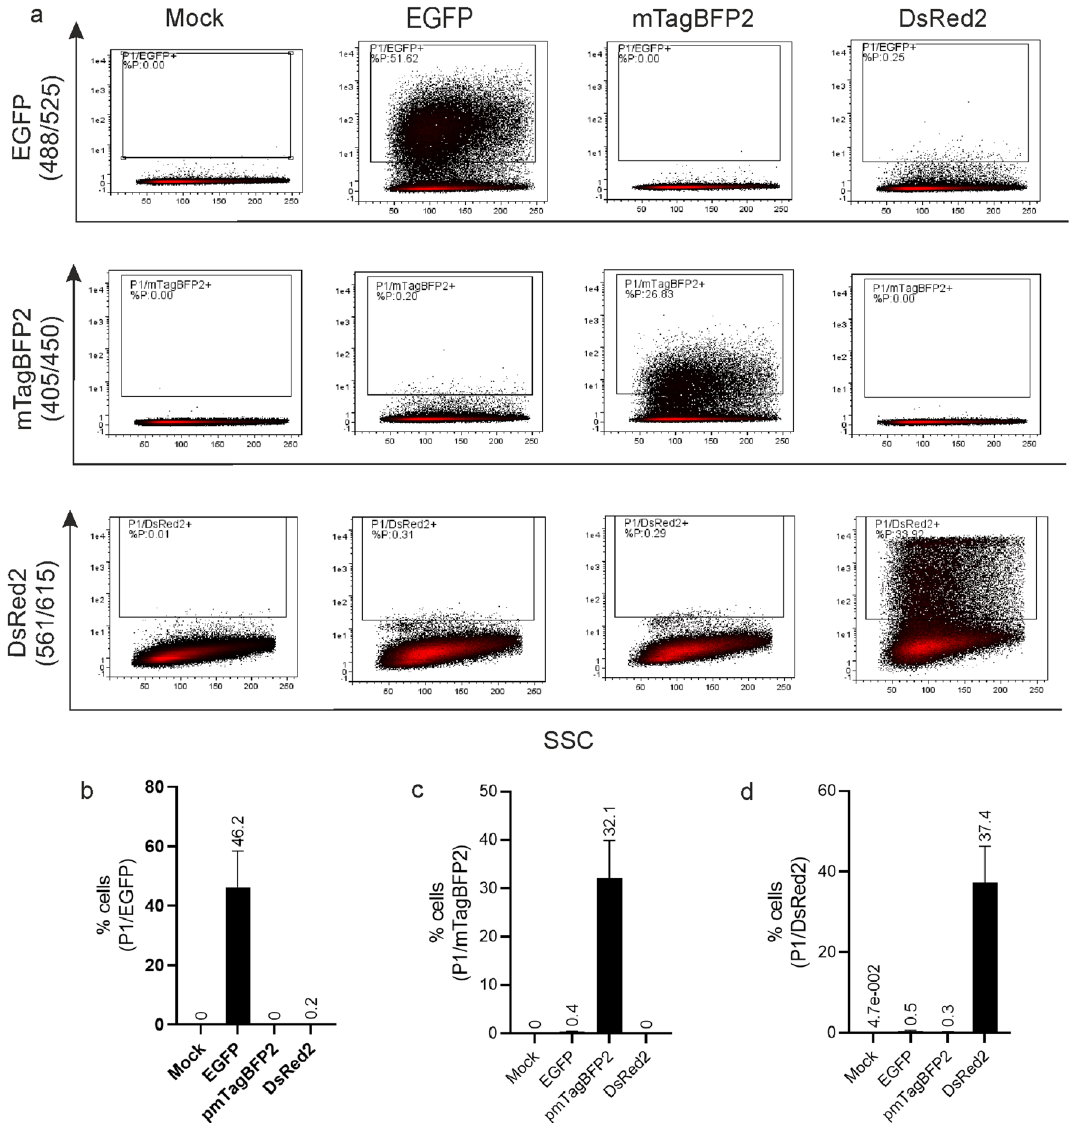
Figure 5. Cross talk of fluorescent proteins. ( a). Representative FACS plots showing the crosstalk level of the three fluorescence proteins after compensation. C33A cells were transfected with control plasmid 250 ng EGFP, 125 ng mTagBFP2 or 125 ng DsRed2 individually. FACS measurement was carried out 48 h post transfection. Living cells (P1) were gated for EGFP, mTagBFP2 and DsRed2 separately to monitor the crosstalk of each fluorescence proteins in respective channel showing cell populations in % cells. EGFP showed a compensable crosstalk signal in the channel of mTagBFP2 and DsRed2. Crosstalk levels were always kept below 0.5% of cell populations in each experiment. ( b, c, d ) . The experiment was repeated three times. The mean % cells of cell populations as gated of three independent biological experiments are plotted in b, c and d with the mean value stated above each bar. The error bars plotted are indicating the standard deviation of mean value from the three independent biological